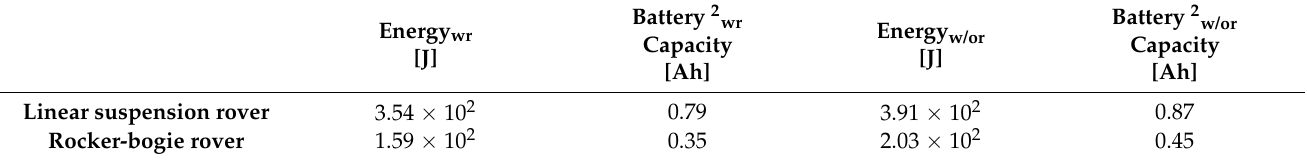
Table 6. Energy 1 consumption levels at lower velocity.